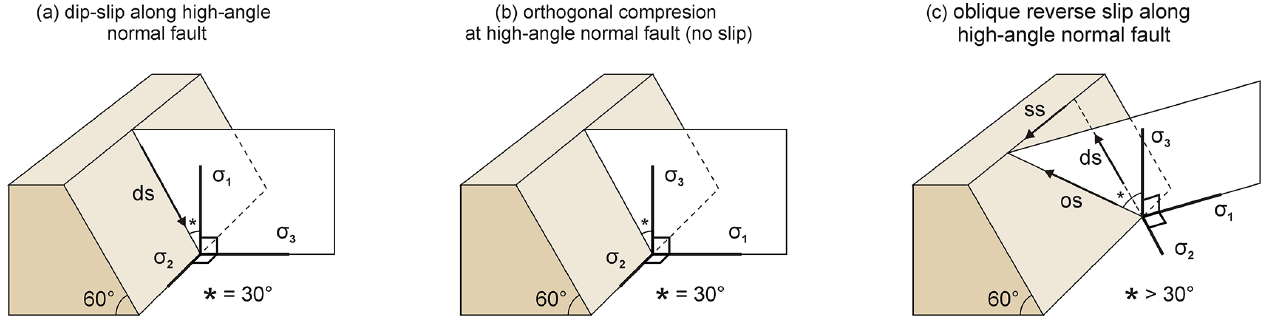
Figure 3. Oblique reactivation of a high-angle normal fault due to the reduced effective fault angle ( ∗ ). Components of deformation are as follows: ds stands for dip-slip, os stands for oblique slip, and ss stands for strike-slip. σ 1 is maximum compressive stress, σ 2 is intermediate compressive stress, and σ 3 is minimum compressive stress. Inspired by Dubois et al. (2002). Note, however, that actual displacements along pre-existing structures can deviate from the directions of the principal stresses (Withjack and Jamison, 1986; Morley,